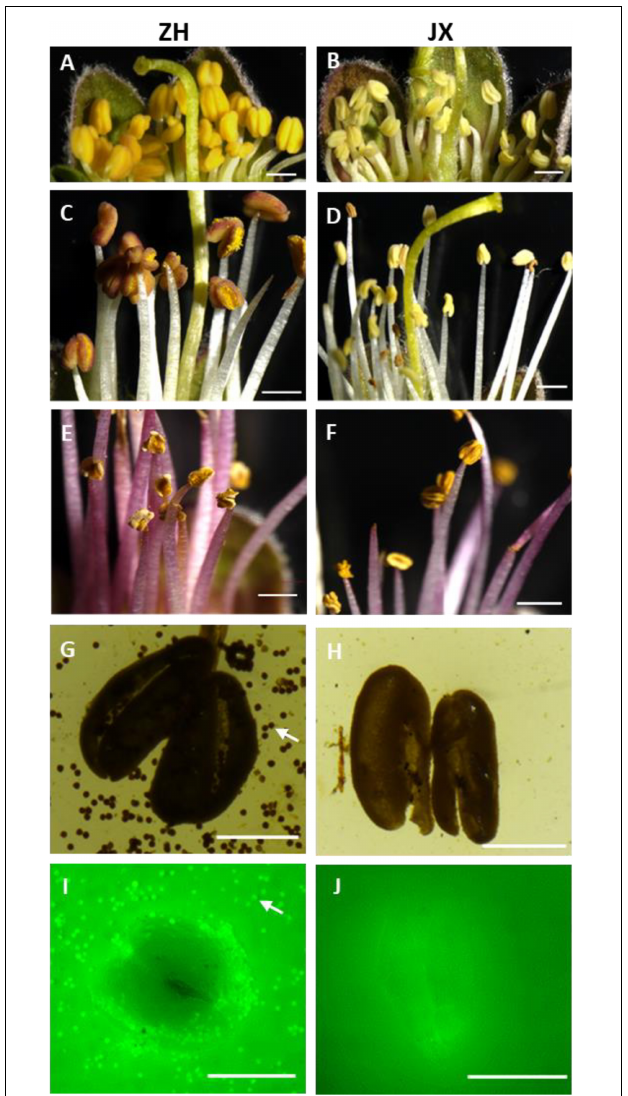
FIGURE 1 | Comparison of anther phenotype between “ZH” and “JX”. Panels (A,B) show swollen and shrunken anthers in flower buds, respectively. (C,D) Anthers at the anthesis. (E,F) Anthers 5 days after flowering. (G,H) Cracked anthers along with pollen grains stained using I 2 /KI. Panels (I,J) cracked anthers and pollen grains stained using FDA. The white arrow indicates pollen grains. The white bar represents 1,000 µ m in (A–F) , and 500 µ m in (G–J) .